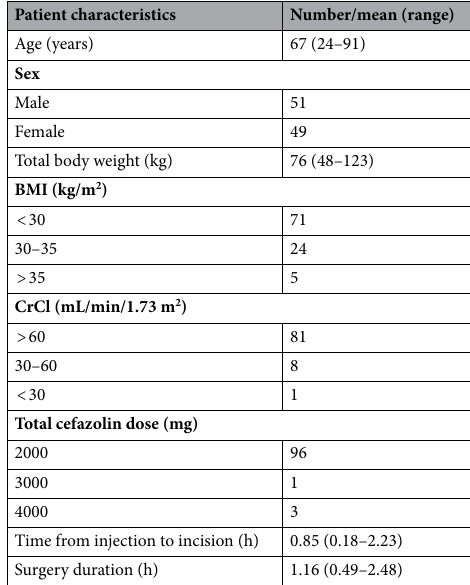
Table 1. Baseline patient characteristics. BMI Body mass index, CrCl Creatinine clearance according to the CKD-EPI formula.